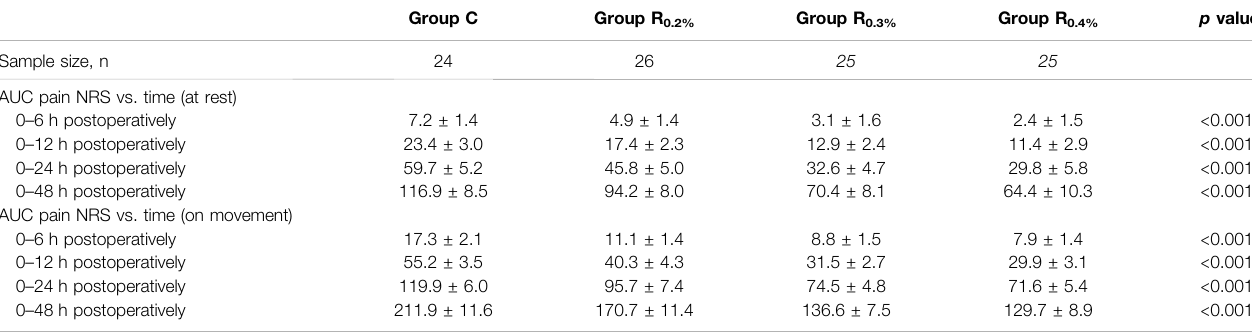
TABLE 3 | The AUC pain NRS vs time at rest and on movement of four groups ( (cid:1) x ±